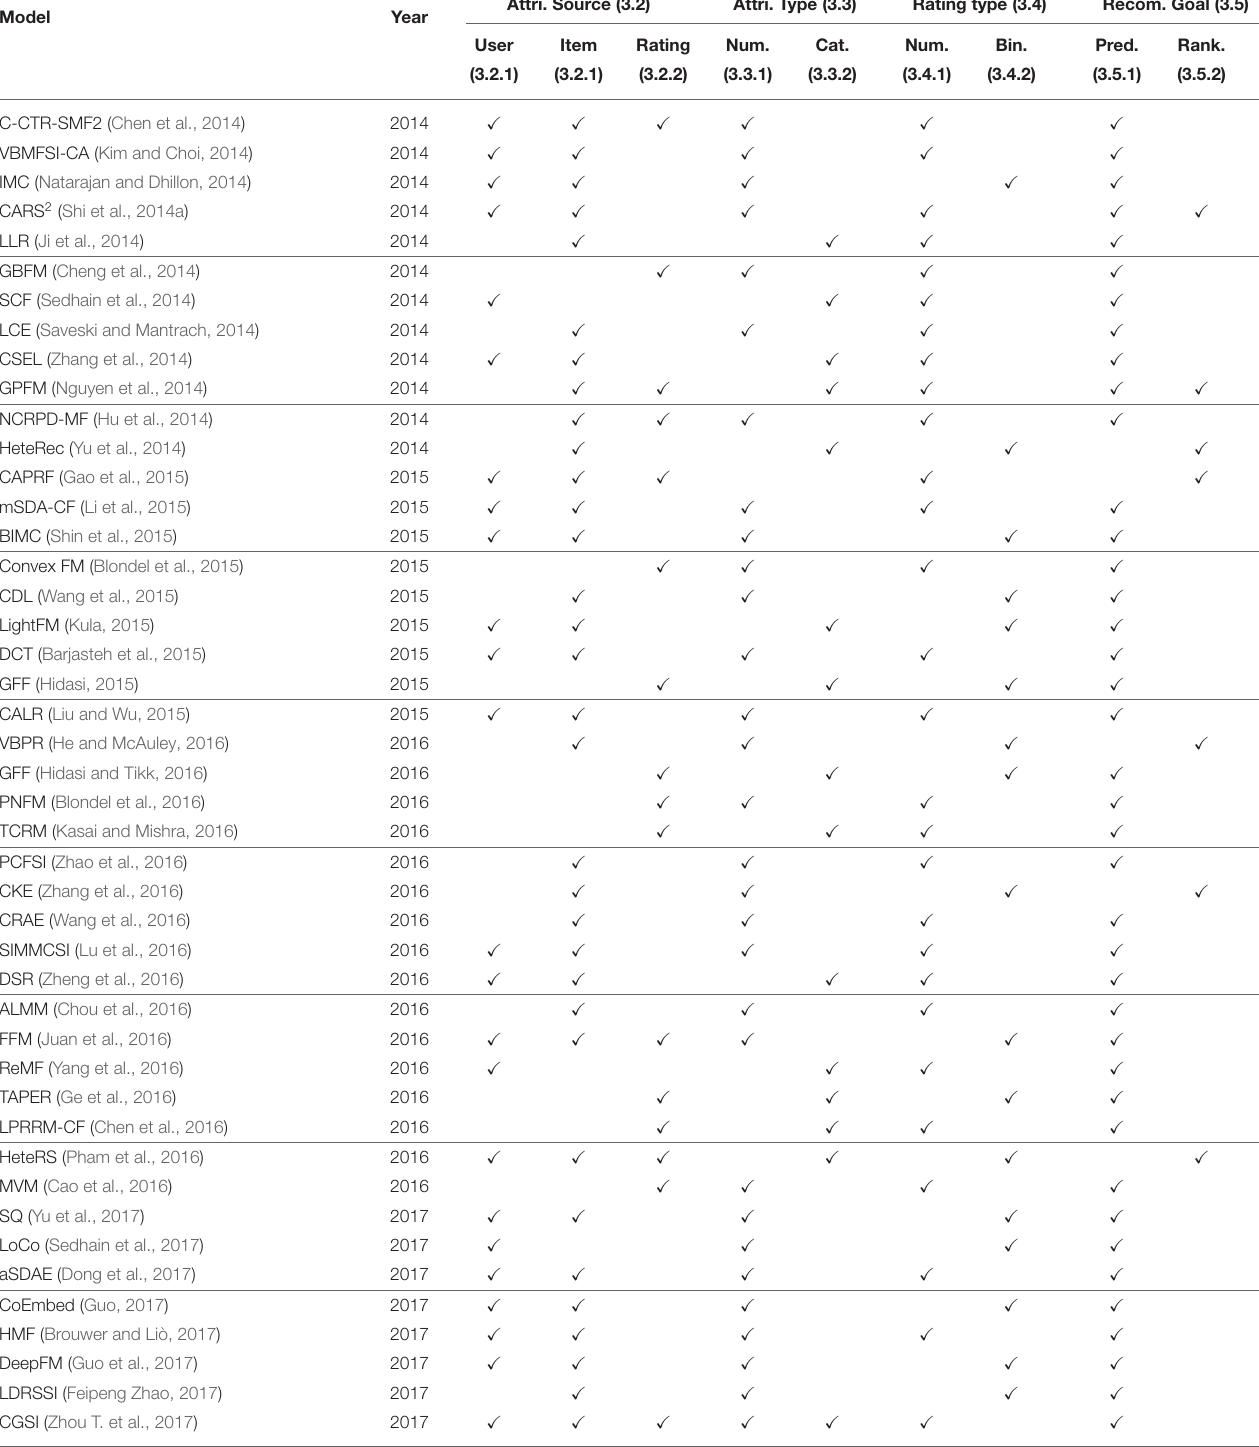
TABLE 3 | List of model